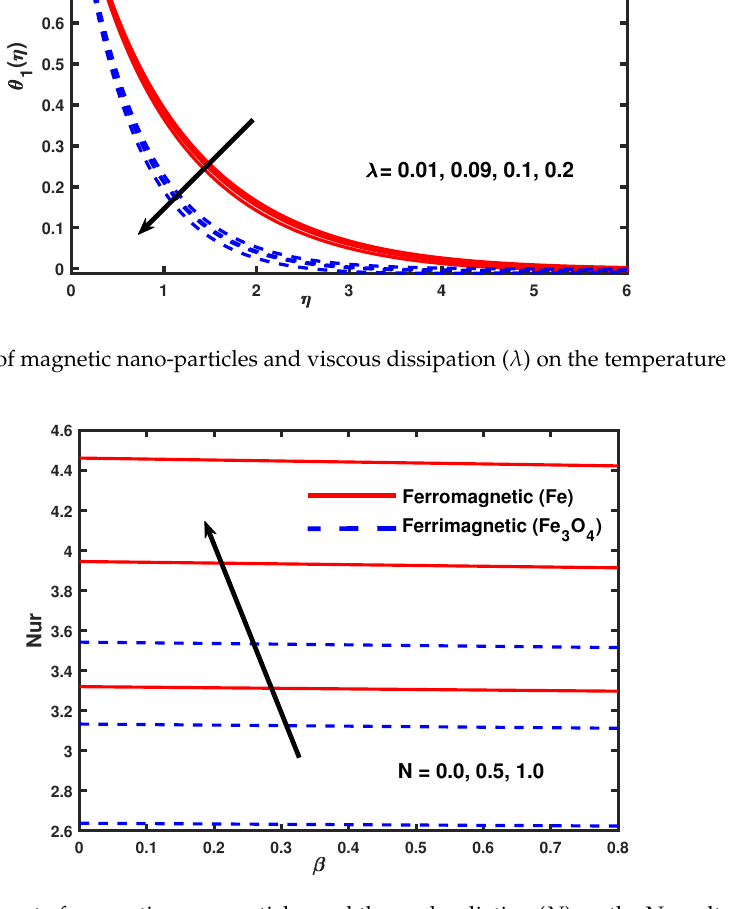
Figure 16. Impact of magnetic nano-particles and thermal radiation ( N ) on the Nusselt